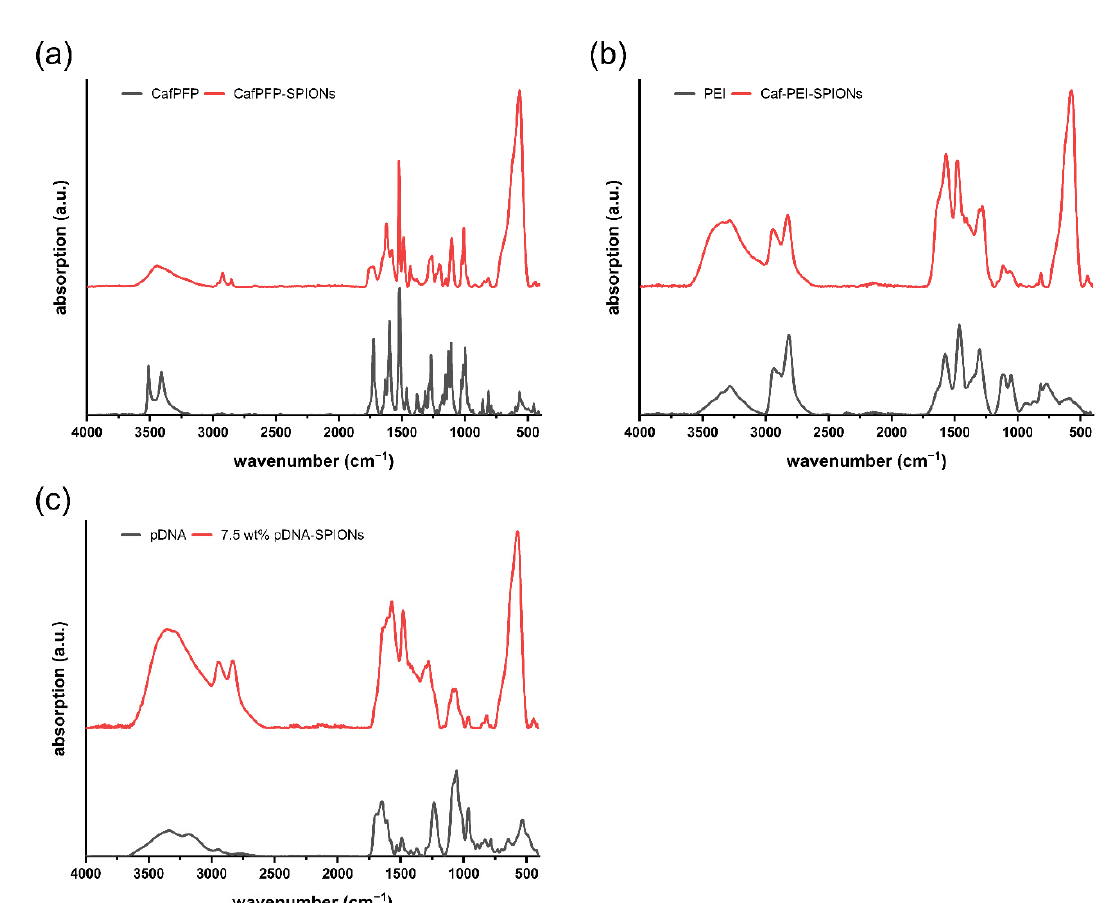
Figure A1. Comparison of FTIR spectra between ( a ) pure CafPFP and CafPFP-SPIONs, ( b ) pure PEI and Caf-PEI-SPIONs and ( c ) pure pDNA and 7.5 wt% pDNA-SPIONs.